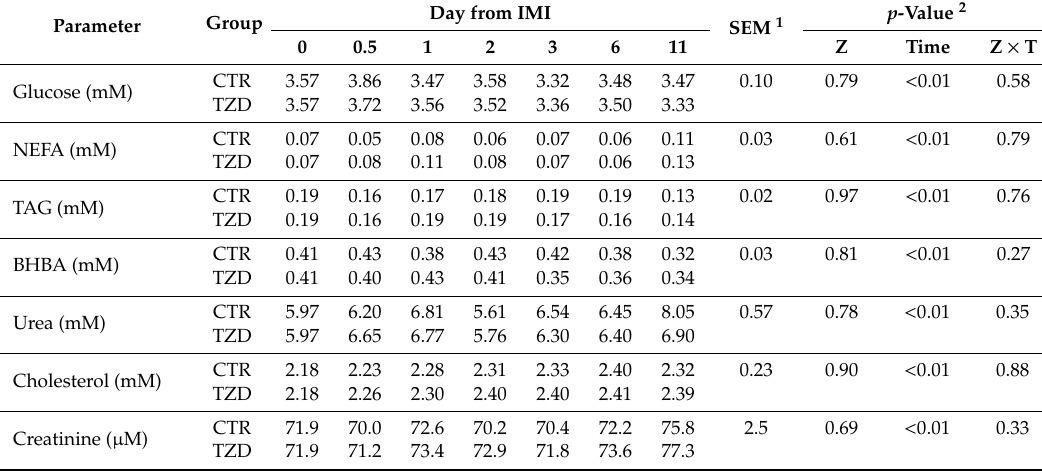
Table 1. Blood metabolic parameters in goats treated with 2,4-thiazolidinedione (TZD) or saline (CTR) after infusion in the right gland of 7 × 10 8 colonies of Streptococcus uberis (i.e., IMI). Day from IMI Parameter Group